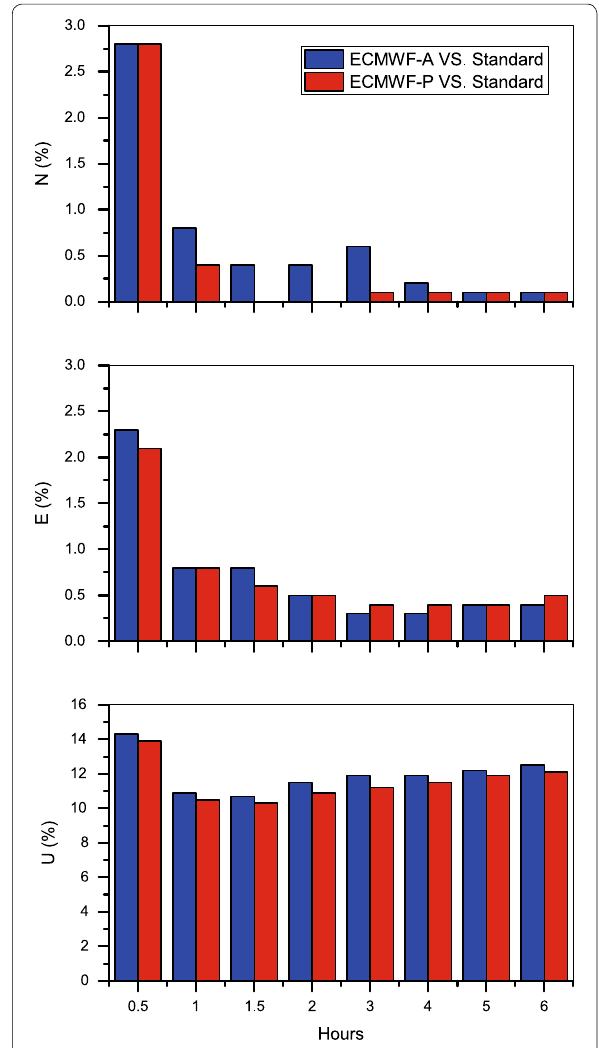
Fig. 8 Specific increased ratios of the two ECMWF-augmented PPP results compared to standard PPP results in BeiDou/GPS PPP at different session length. Blue and red stand for the improvements in percentage for ECMWF-augmented PPP results using analysis and prediction data,